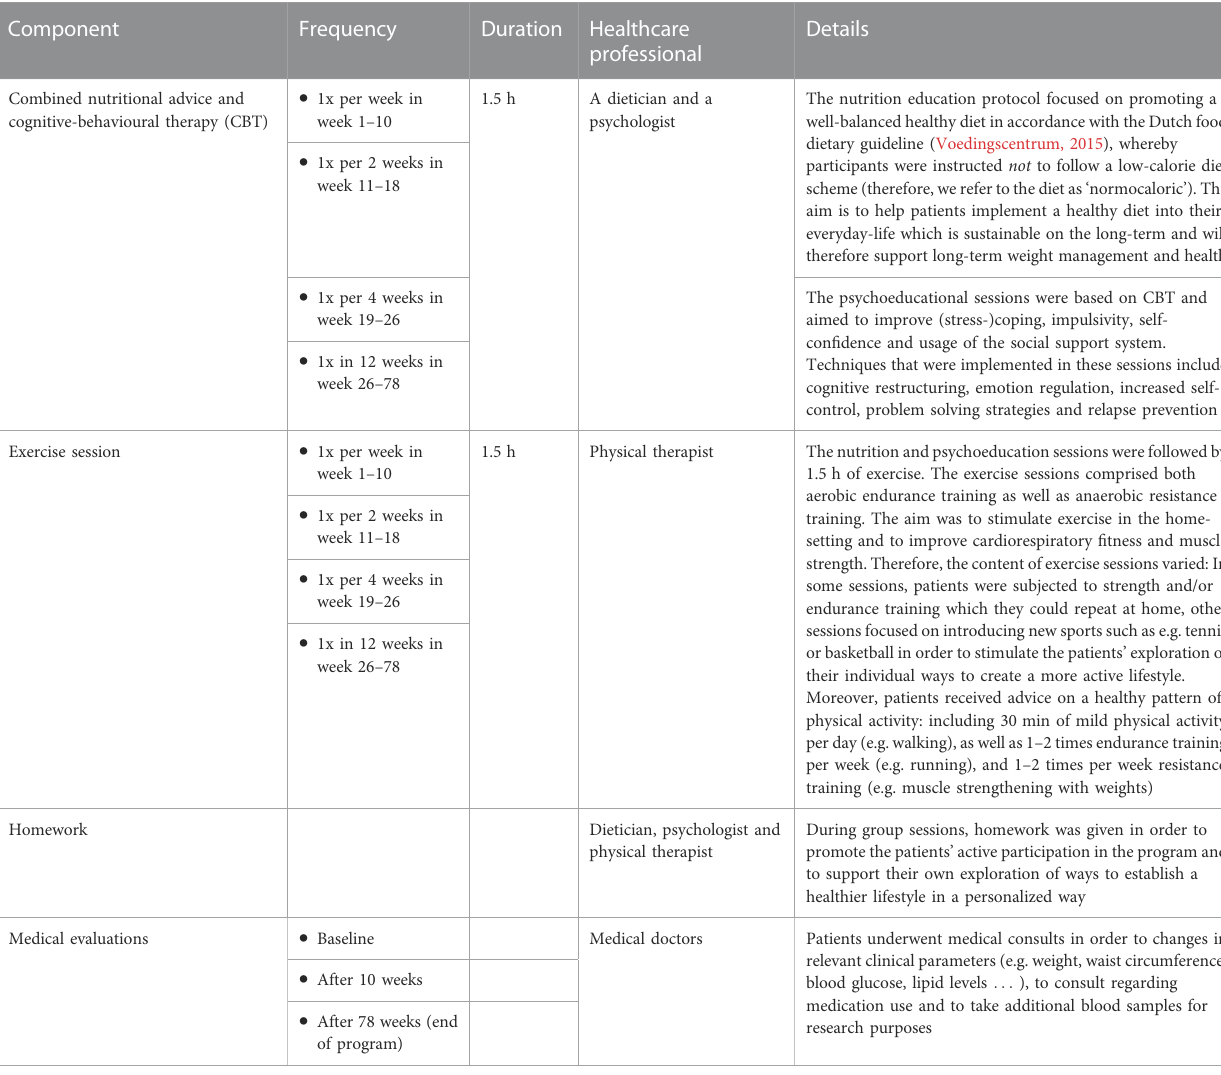
TABLE 1 Detailed description of the combined lifestyle intervention (CLI).